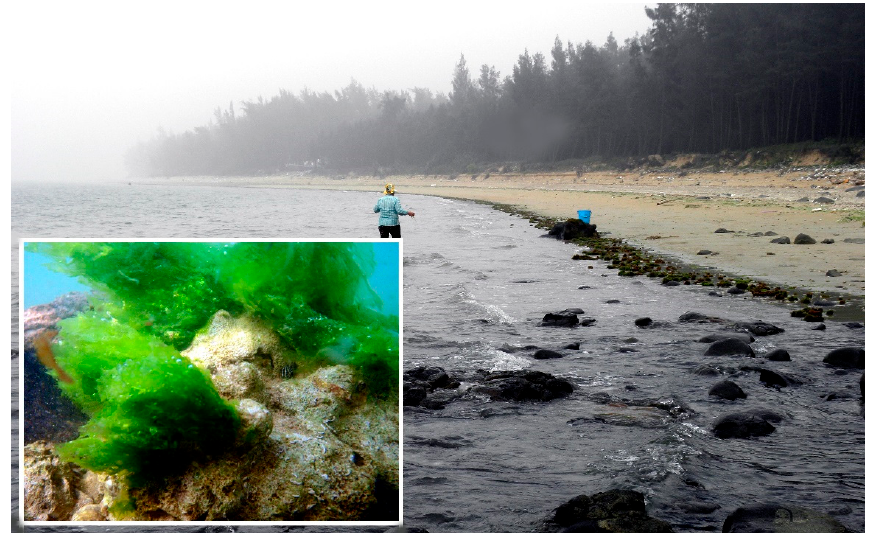
Figure 6. Meixia locality. Inset: Monostroma latissimum on dead coral block in the low intertidal zone, April 2012.